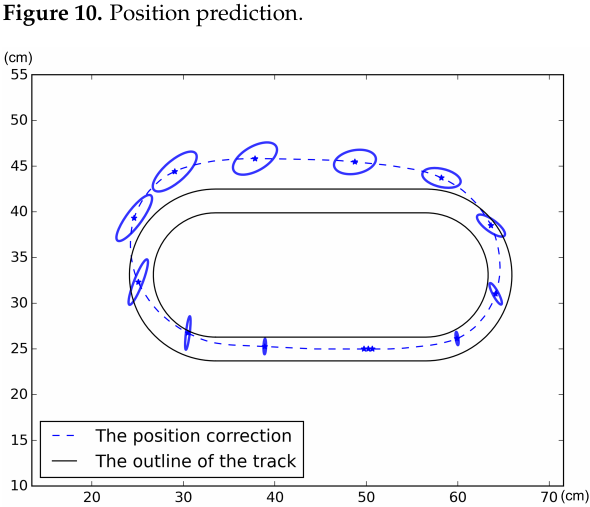
Figure 11. Position